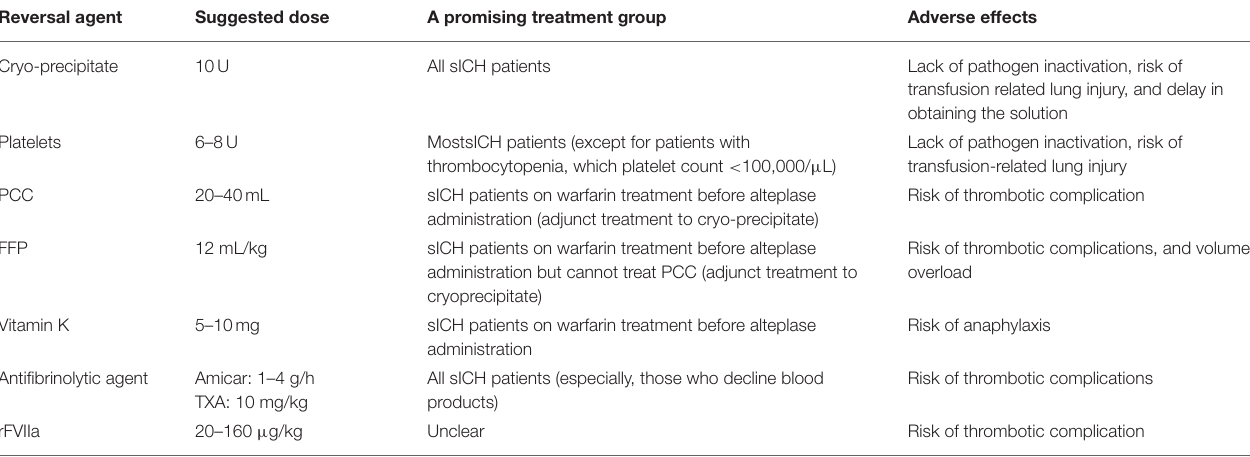
TABLE 3 | Potential reversal agents for treatment of HT. Reversal agent Suggested dose A promising treatment group Adverse effects Cryo-precipitate